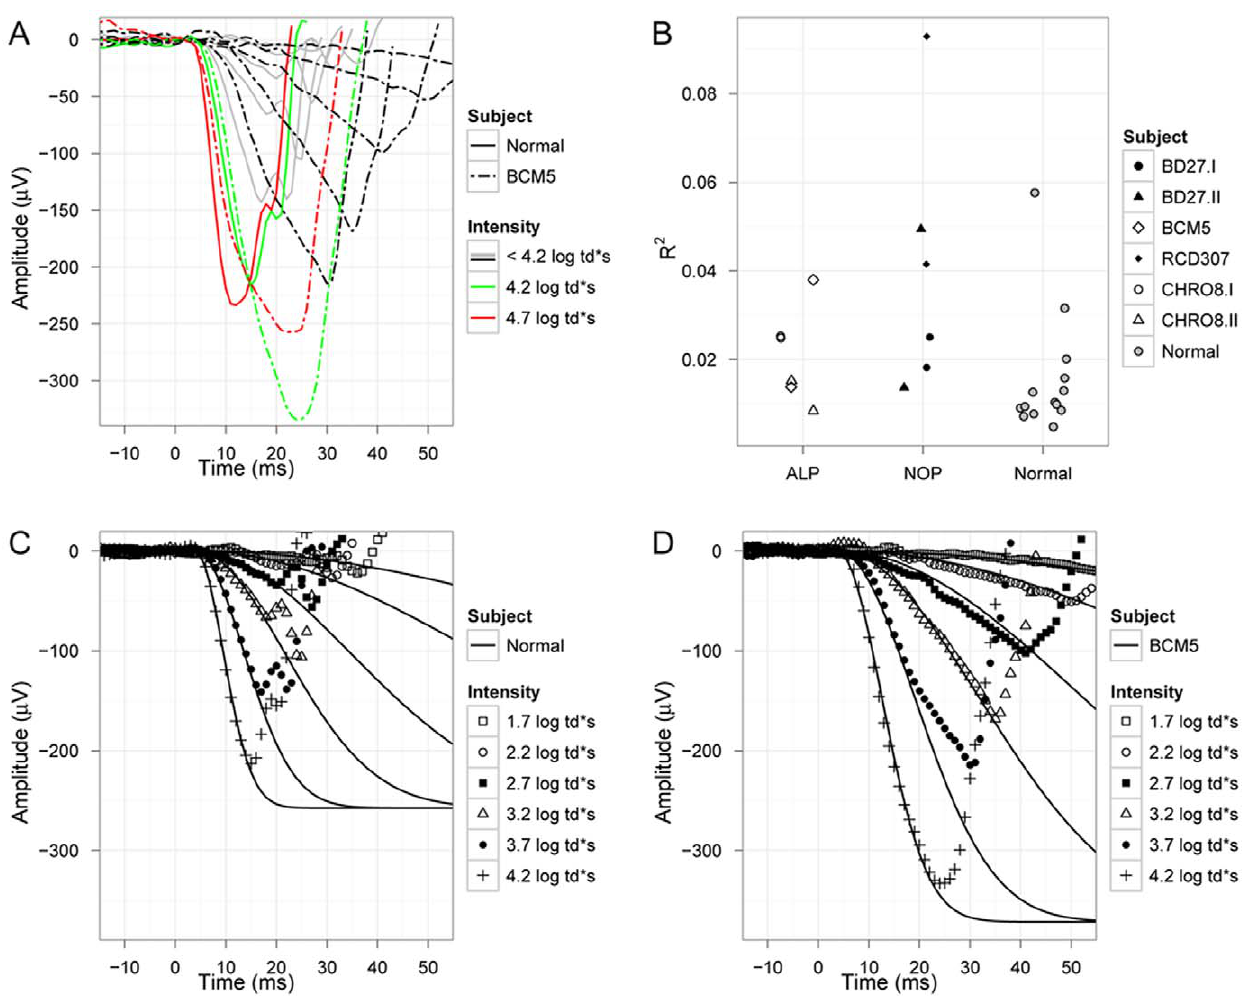
Figure 5. Analysis of the scotopic a-wave ( P III response). (A) Scotopic response a-waves to increasing flash intensities show continuous increasing response amplitudes in the normal subject (full lines). The patient’s responses (chain lines) also show continuous increasing amplitudes up to a flash intensity of 4.2 log td*s (green color coding), but a lower response amplitude to the flash with highest intensity (red color coding). Therefore responses to highest flash intensity were excluded from a-wave analysis. Interestingly, while R 2 of the fits in normal subjects was above 0.02 in 2 eyes only, it was higher in 7 of the patient eyes (B). The difference in goodness of the fit is seen in the normal subject (C) and in the representative patient BCM5 (D).